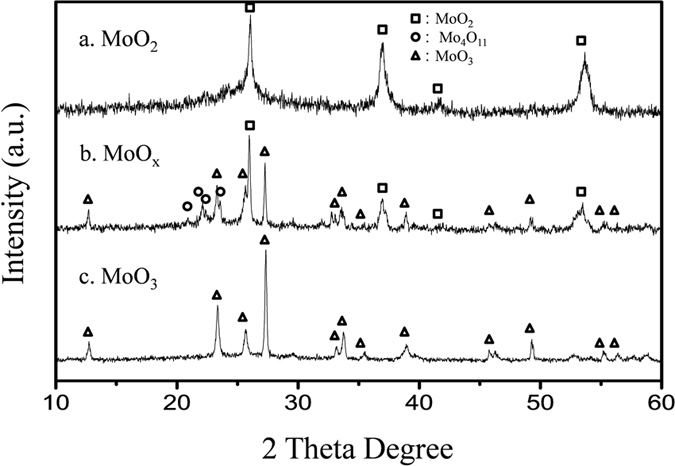
XRD patterns of the MoO2 nanoparticles annealed in N2 flow with different O2 content ((a), 0%; (b), 0.2%; (c), 1% O2 in N2).